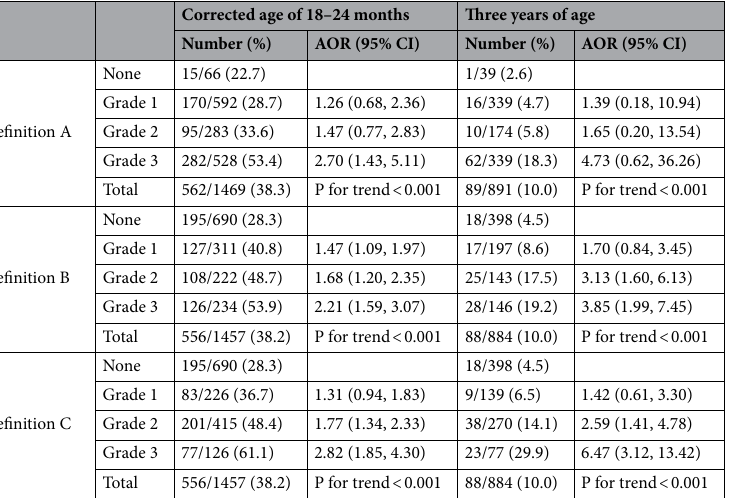
Table 4. Growth restrictions at a corrected age of 18–24 months and at 3 years of age according to the severity of bronchopulmonary dysplasia per each definition. AOR adjusted odds ratio; CI confidence interval. ORs were adjusted for gestational age, small for gestational age, intraventricular hemorrhage (≥ grade 3), periventricular leukomalacia, necrotizing enterocolitis (≥ stage 2), retinopathy of prematurity (requiring surgery), and sepsis using multivariable logistic regression. Growth restriction was defined as z-scores < − 1.28 (equivalent to < 10th percentile) of weight, height, or head circumference by the 2006 World Health Organization Child Growth Standards, meaning failure of catch-up growth.